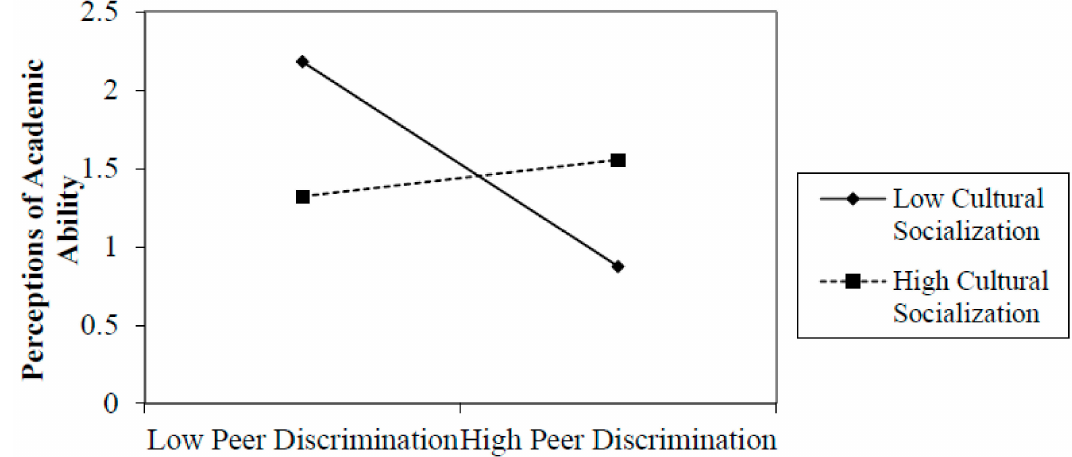
Figure 3. Perceptions of Academic Ability: Cultural Socialization by Peer